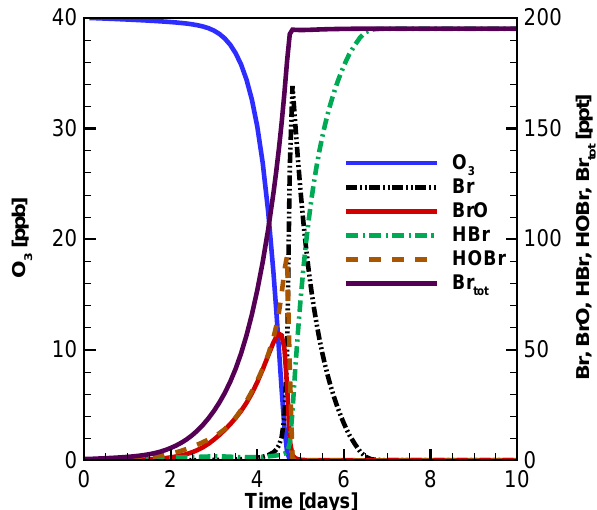
Figure 1. Temporal evolution of ozone and principal bromine- containing compounds in a 200m boundary layer, obtained by using the original reaction scheme in the model (Cao et al.,